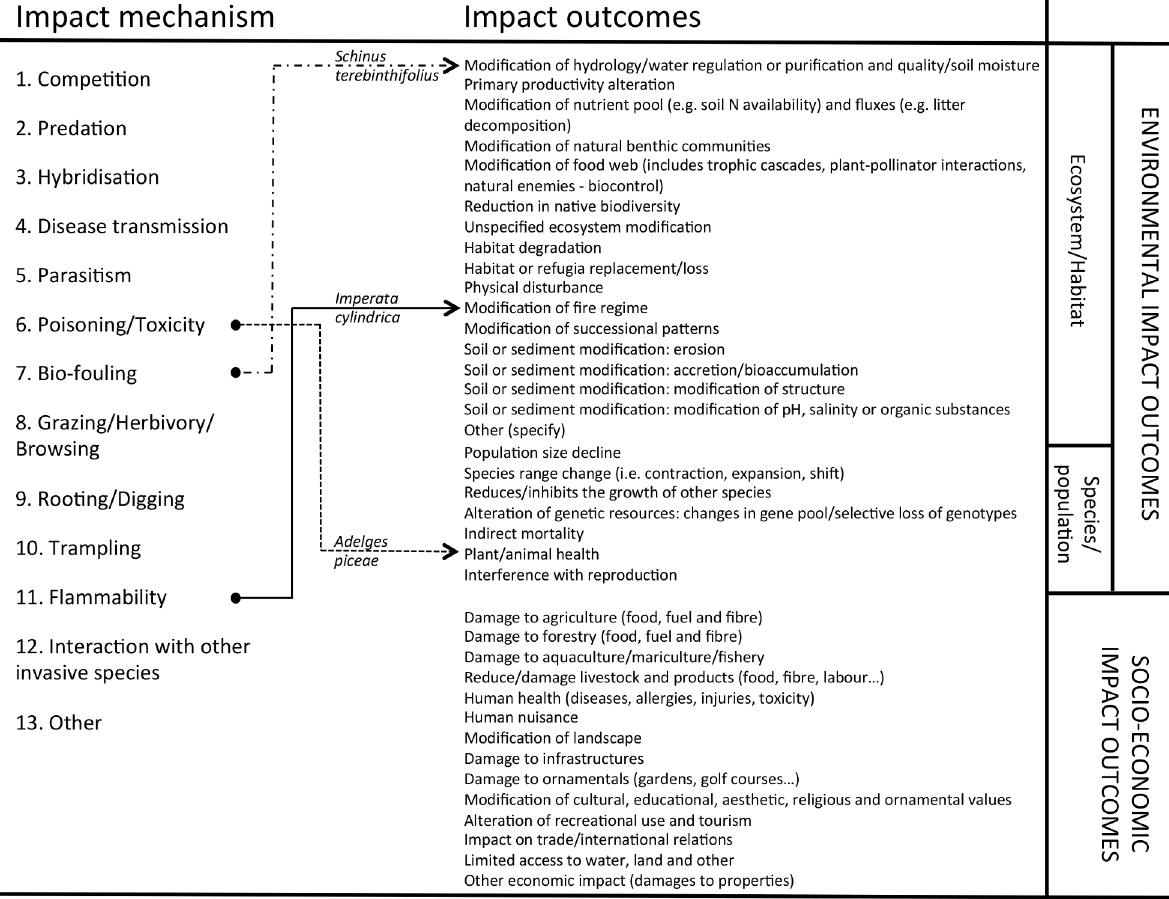
impact reported is considered. We ac-